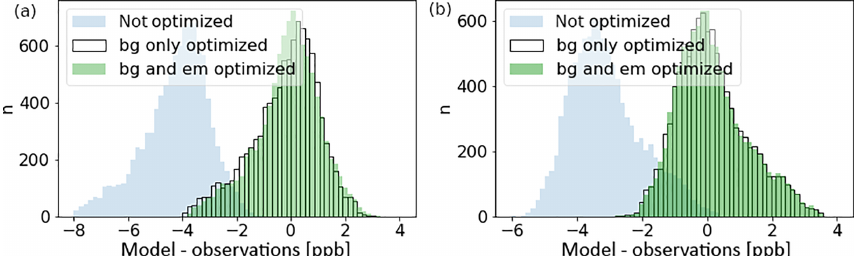
Figure 11. Comparison of prior and posterior misfits of the WRF model to the MOPITT retrievals: (a) year 2002, (b) year 2006. Blue bars depict the difference between the model and satellite data before optimization, white bars the difference after background optimization and green bars the difference after background and emission